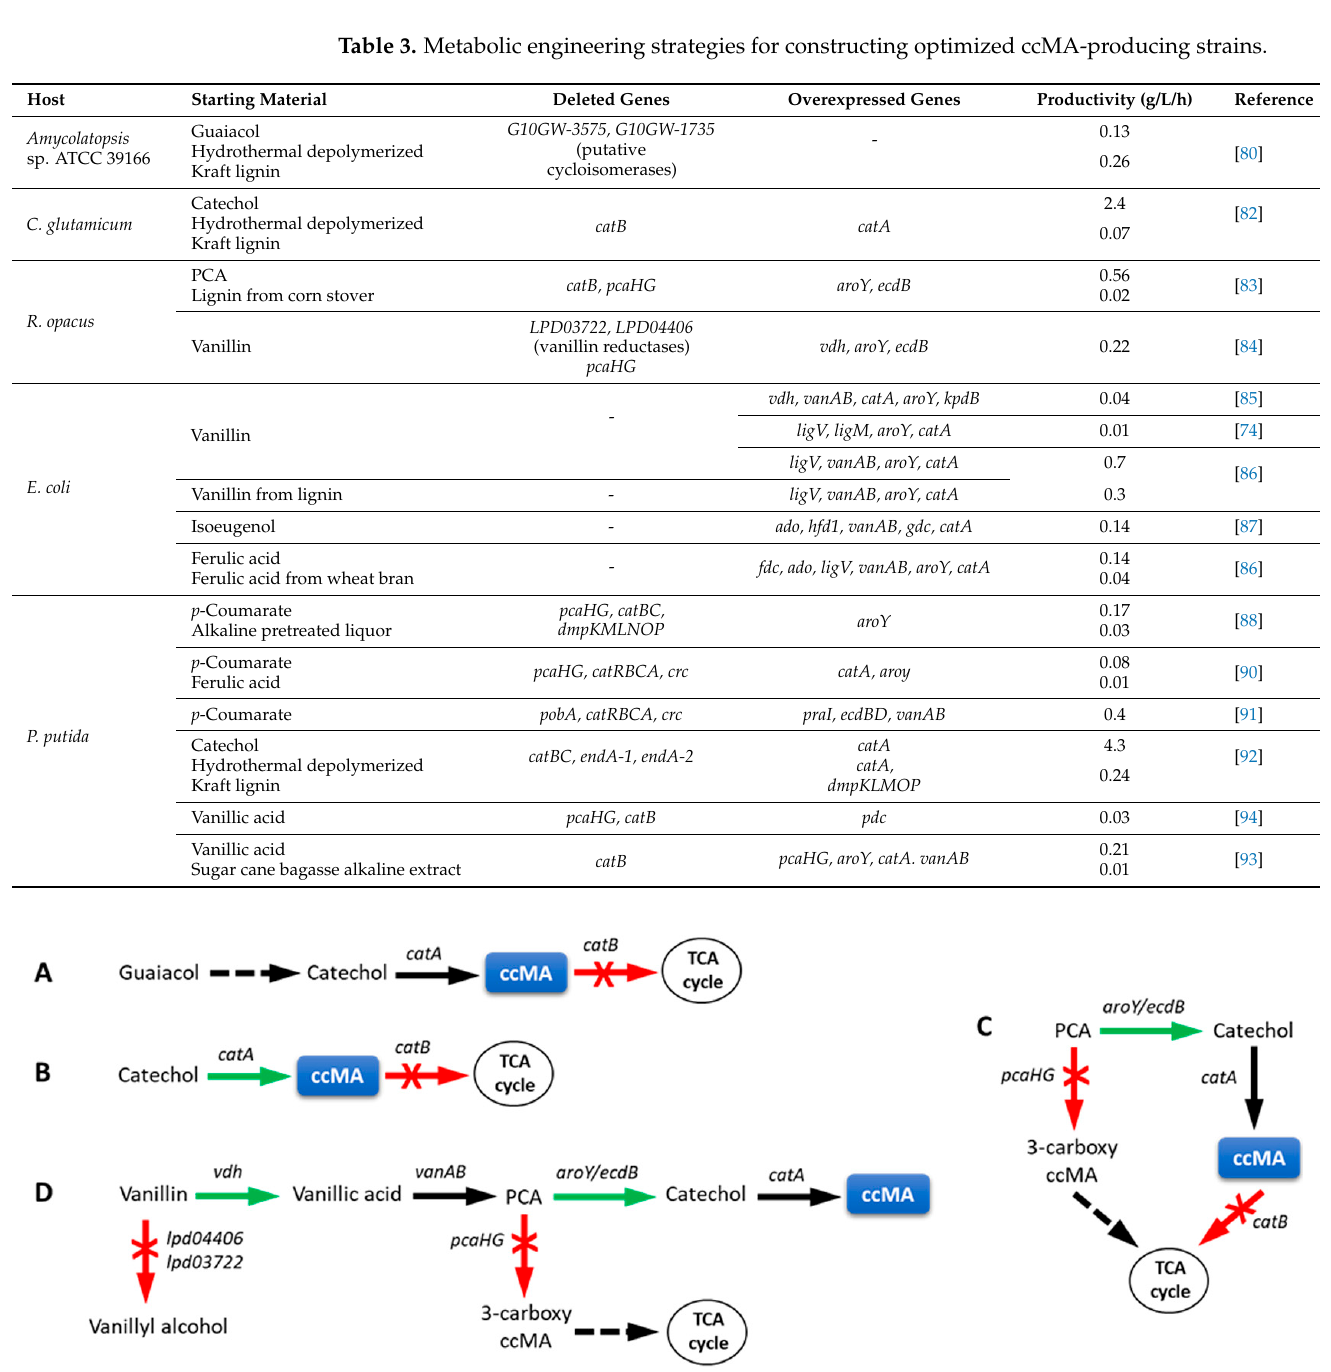
Figure 3. Scheme of ccMA production from engineered ( A ) Amycolatopsis sp. ATCC 39166 [80], ( B ) Corynebacterium glutamicum [82], and ( C , D ) Rhodococcus opacus [83,84]. Encoding genes: aroY , protocatechuate decarboxylase; catA , catechol 1,2-dioxygenase; catB , muconate cycloisomerase; ecdB , flavin prenyltransferase; lpd03722 and lpd04406 , putative vanillin reductases; pcaHG , protocatechuate 3,4-dioxygenase; vdh , vanillin dehydrogenase; vanAB , vanillate demethylase. Black arrows show the endogenous pathway; green arrows show overexpressed pathways; red crossed arrows identify deleted pathways; dashed arrows show additional multi-step pathways.